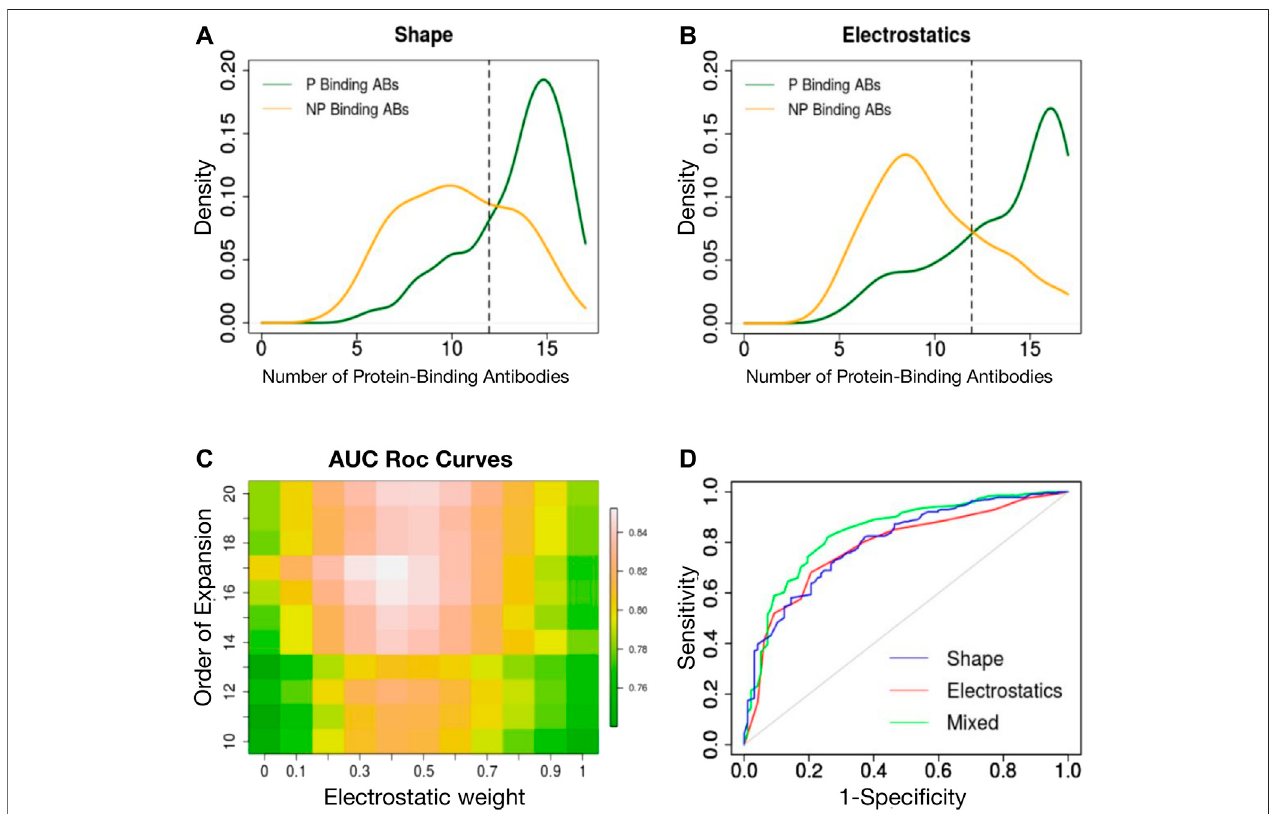
FIGURE 2 | (A) Density distribution of protein binding antibodies ( N pb ) in the neighbours set of protein binding (green curve) and non-protein binding antibodies (orange curve) based on surface shape similarity. (B) Density distribution of protein binding antibodies ( N pb ) in the neighbours set of protein binding (green curve) and non-proteinbindingantibodies(orangecurve)basedonelectrostaticsurfacesimilarity. (C) Classi fi cation performance(ROCAUC)isreportedasafunctionoftheordern of the Zernike expansion and weight of the average. (D) ROC curve of the best classi fi er based on shape 3DZD (blue curve), electrostatic 3DZD (red curve) and weighted average N pb (green